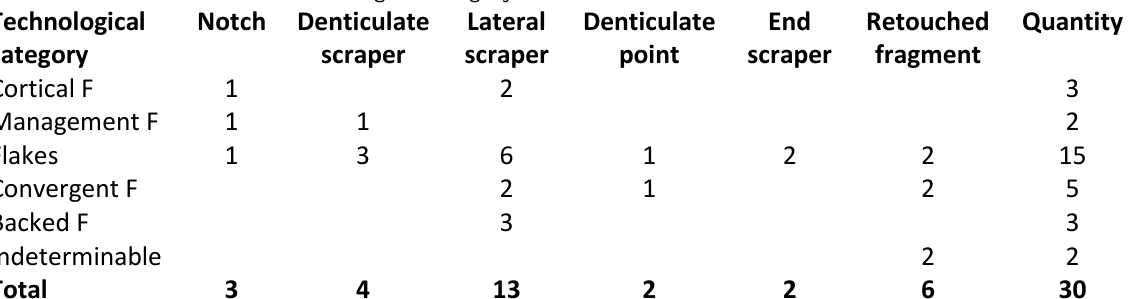
Table 4. Retouched tools and technological category.